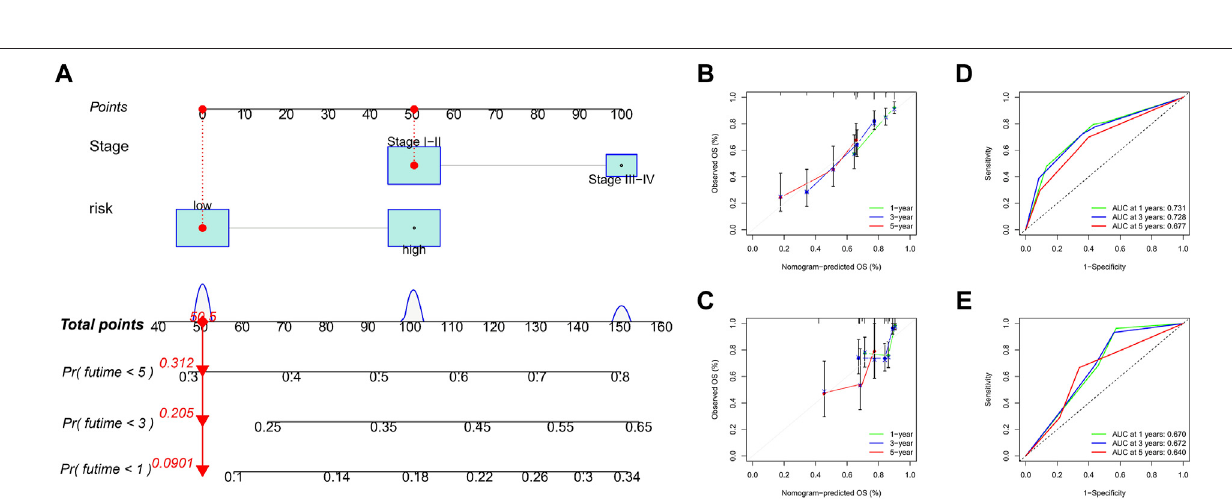
( Figure 9C ). ESTIMATE is a tool that uses gene expression data to predict tumor purity and the presence of in fi ltrating stromal/ immune cells in tumor tissue (Yoshihara et al., 2013). We used the ESTIMATE algorithm to evaluate the composition of immune cells in each sample by stromal score, immune score, estimated score, and tumor purity; the results showed that the high-risk group had higher stromal, immune, and estimated scores ( Figure 9B ). We then